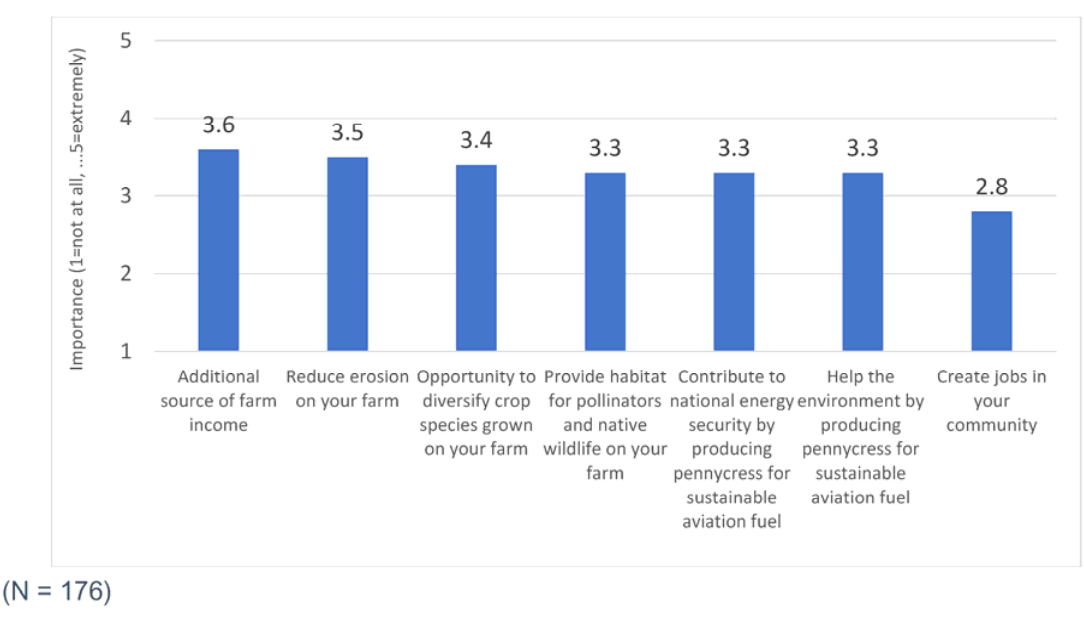
Figure 4. Importance of potential benefits decision to grow pennycress among row crop farmers in seven US states.